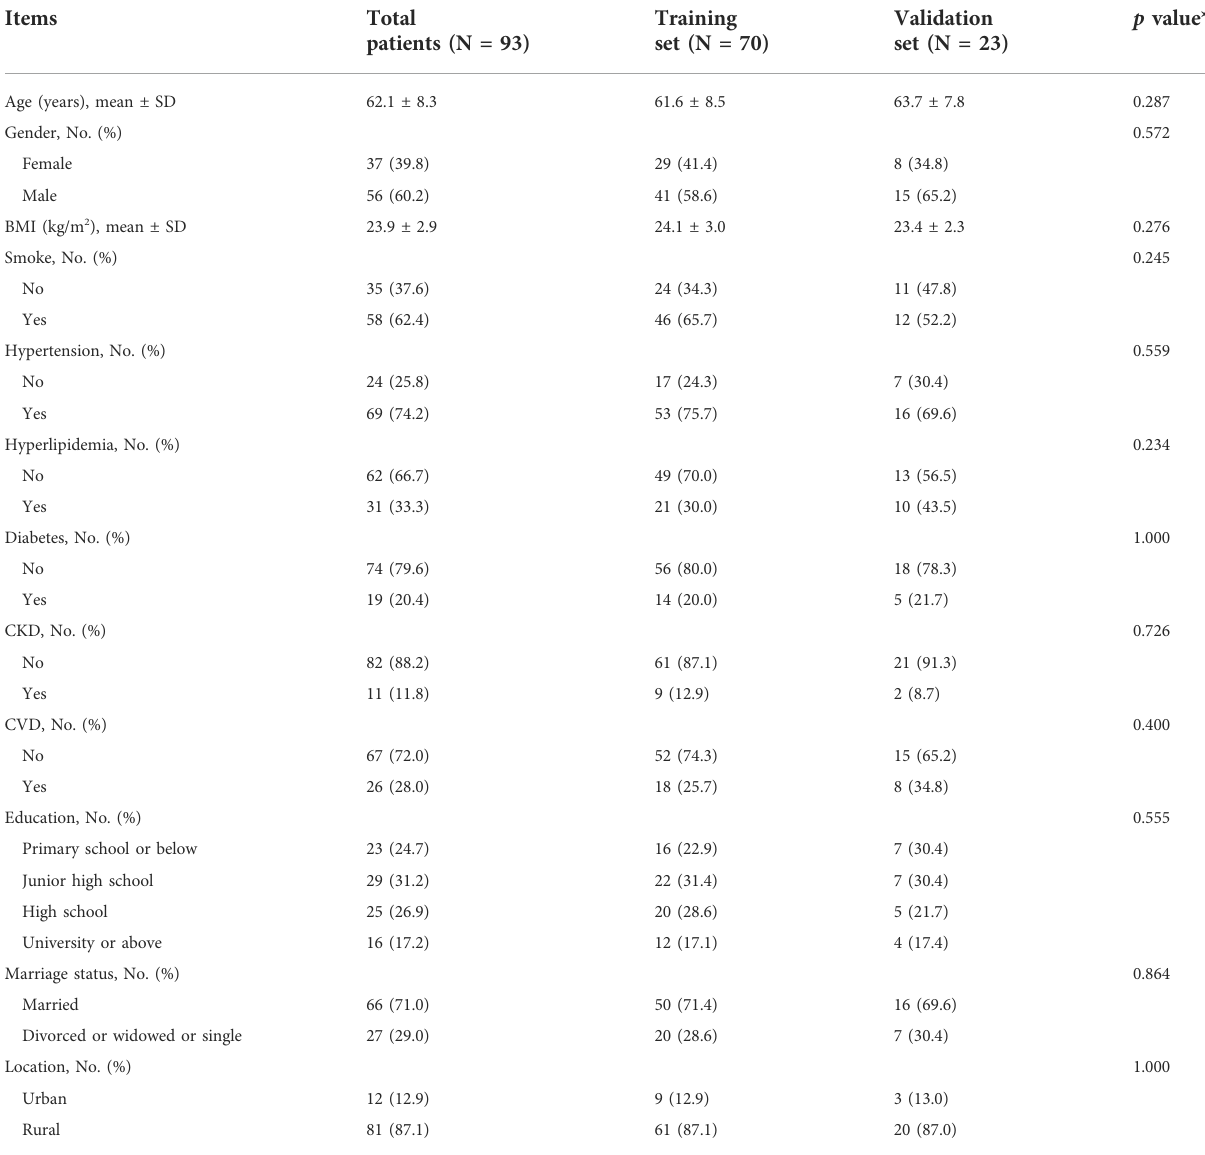
TABLE 1 Clinical